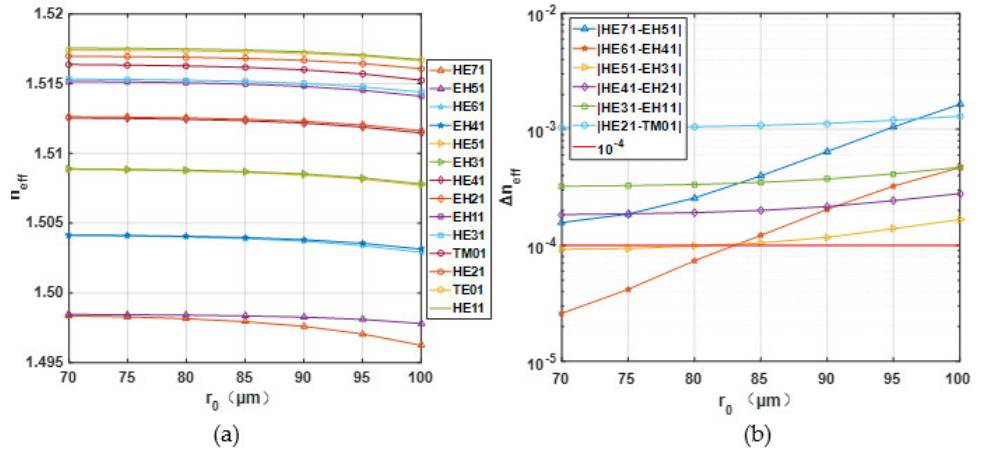
Figure 2. ( a ) The effective refractive index as a function of the air hole radius r 0 for different vector modes. ( b ) The effective refractive index difference as a function of the air hole radius r 0 for EH and HE modes.